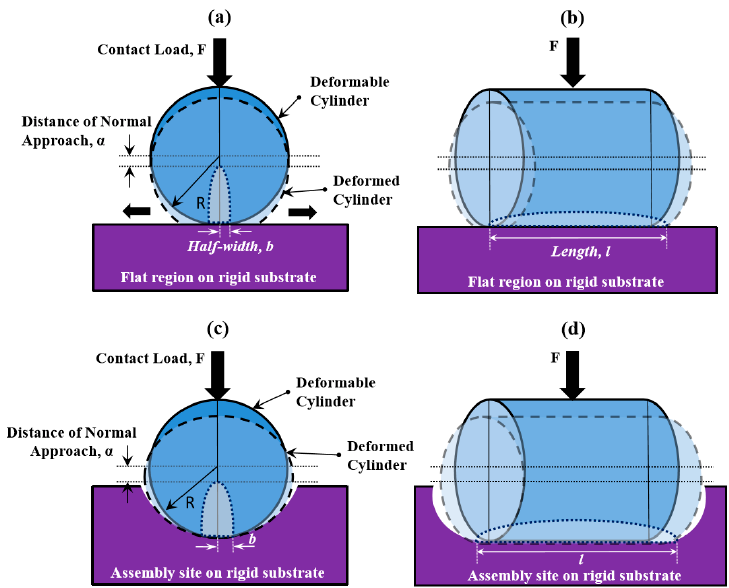
Figure 1. ( a , b ) Schematic diagrams of cylindrical components located within hemicylindrical wells that have rounded end caps shown in an axial view (a) and in a side view (b). ( c , d ) Schematic diagrams of cylindrical components located on a flat surface shown in an axial view (c) and in a side view (d). The original geometry is shown with solid outlines in darker blue, and the deformed geometry for the case of Hertzian contact under the influence of a contact load is shown with dotted outlines in lighter